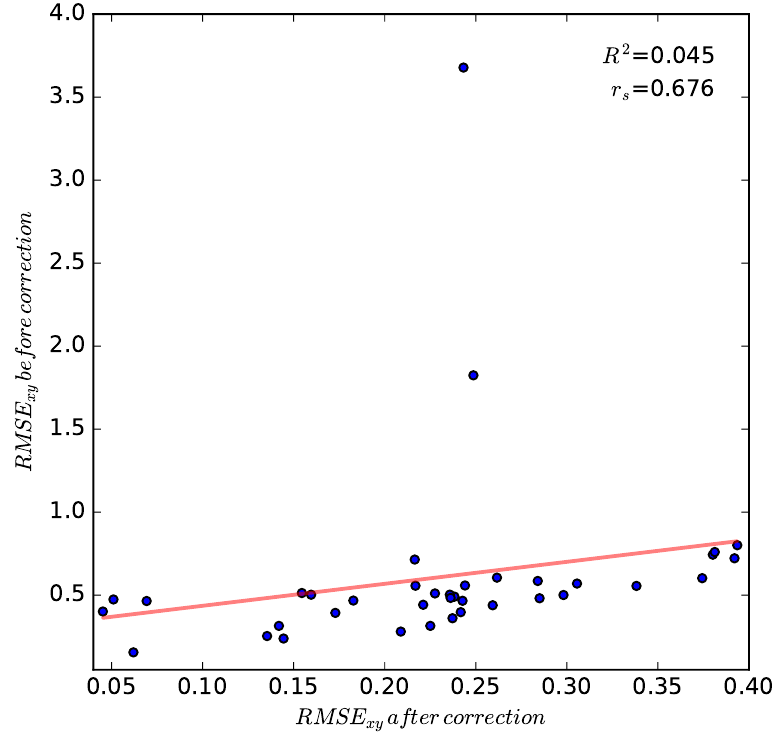
Figure 7. Relationship between the RMSE xy before and after correction for the time-series (31TGK, master 23 August 2016). Due to two outliers the relationship is characterized by a low Pearson’s R 2 but shows a monotonic behaviour indicated by a high Spearman rank correlation r s